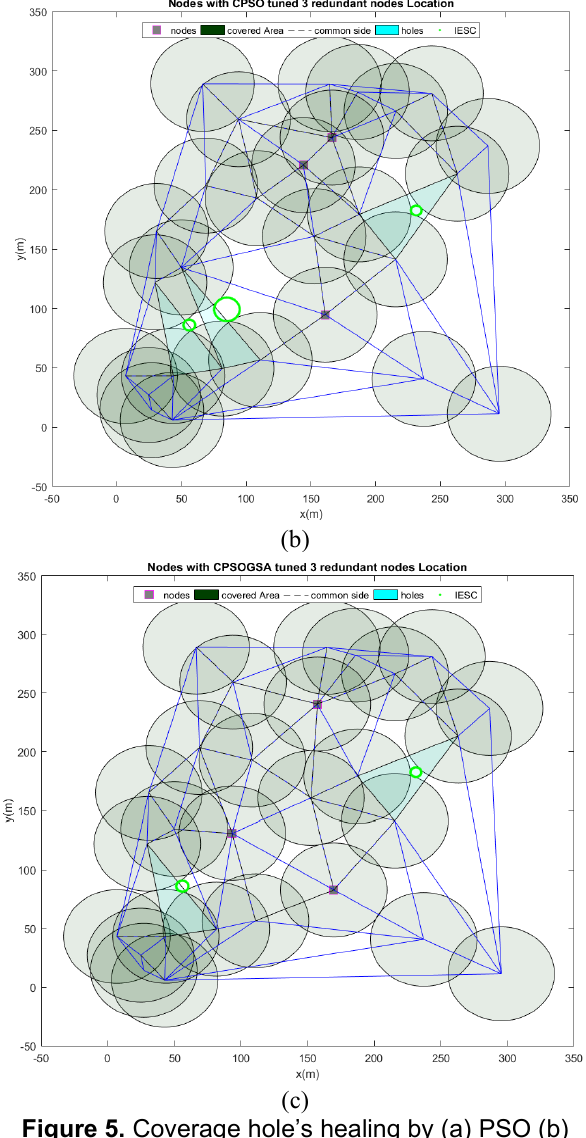
Figure 5. Coverage hole’s healing by (a) PSO (b) CPSO (c) PSOCGSA Table 3. State of art comparison with proposed approach